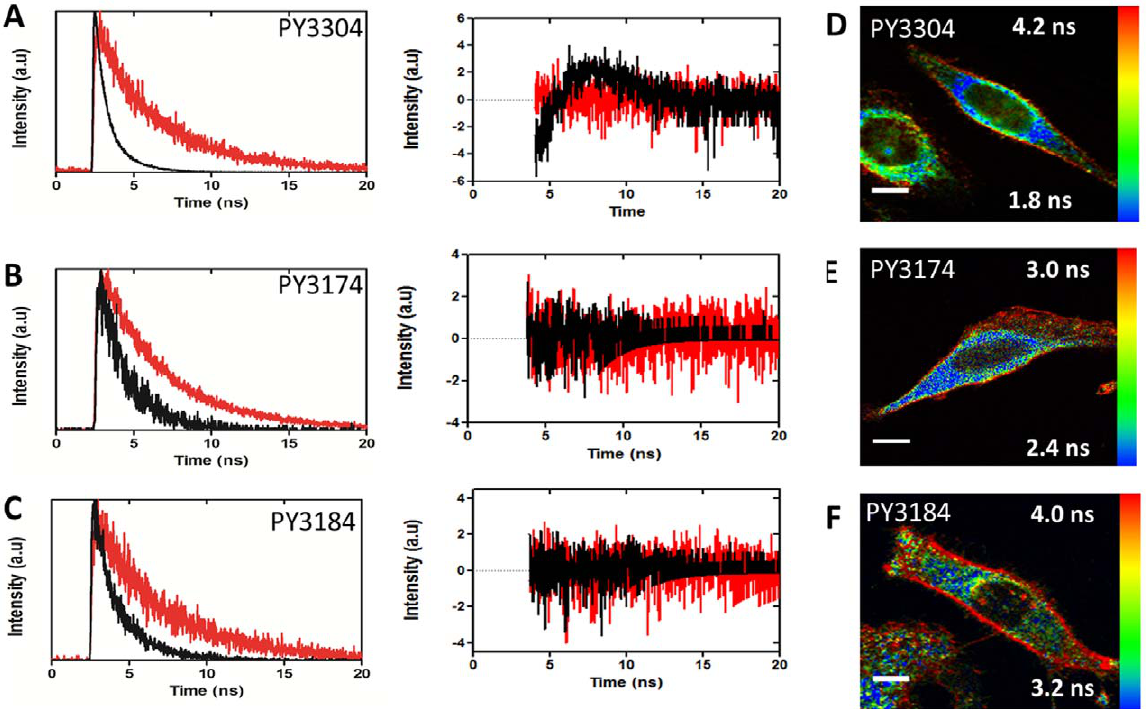
Figure 5. Analysis of FLIM images. Left: Fluorescence decay histograms acquired from artificial membranes stained with PY3304 (A), PY3174 (B) and PY3184 (C) showing longer lifetimes in ordered membranes (red) than disordered membranes (black). Middle: Plots of residuals from fitting fluorescence decay histograms. (D-F) Right: Fluorescence lifetime images of live HeLa cells stained with PY3304 (D), PY3174 (E), PY3184 (F). Images show an increased order at the plasma membrane in agreement with the spectral measurements and previously published results. Scale bar =10 m m.